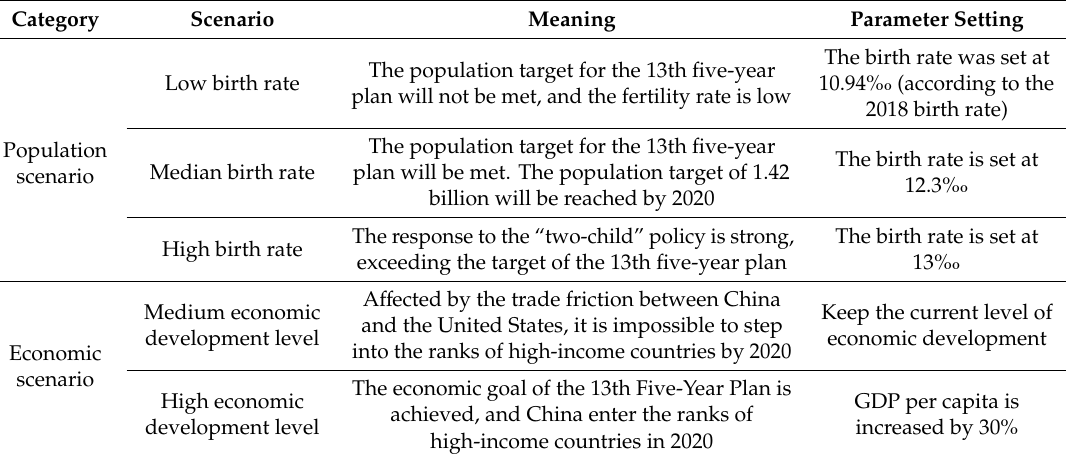
Table 1. Scenario parameter setting and